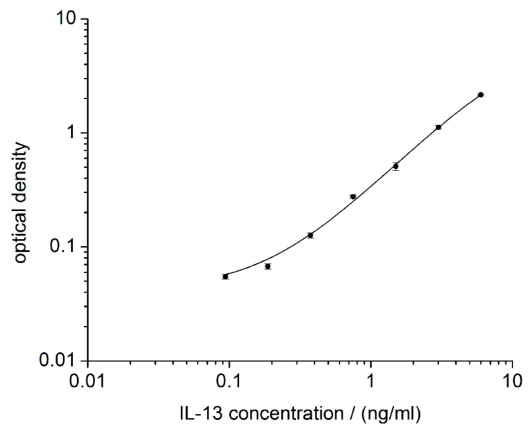
Figure 3. IL-13 ELISA as reference. Logarithmic representation of optical density vs. IL-13 concentration. For each concentration, duplicates were prepared according to the manufacture’s protocol. Read-out was performed at 450 nm and at 540 nm. Values at 540 nm were subtracted from values at 450 nm to correct for optical imperfections of the plate.